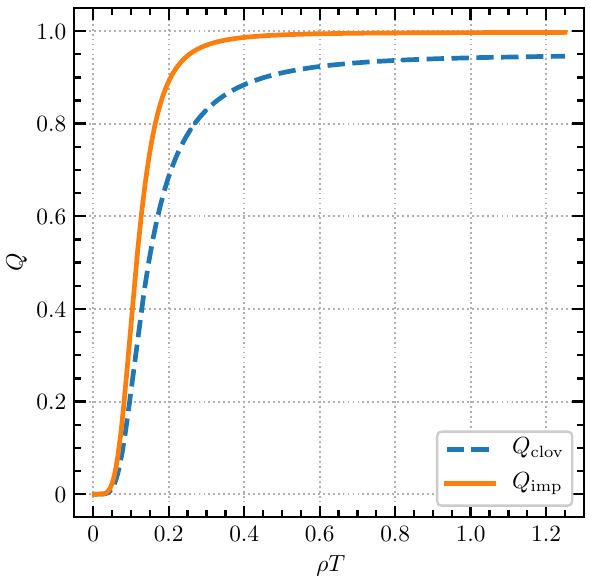
Fig. 2 Two different discretizations of the topological charge operator as a function of the caloron size on an 8 × 32 3 lattice